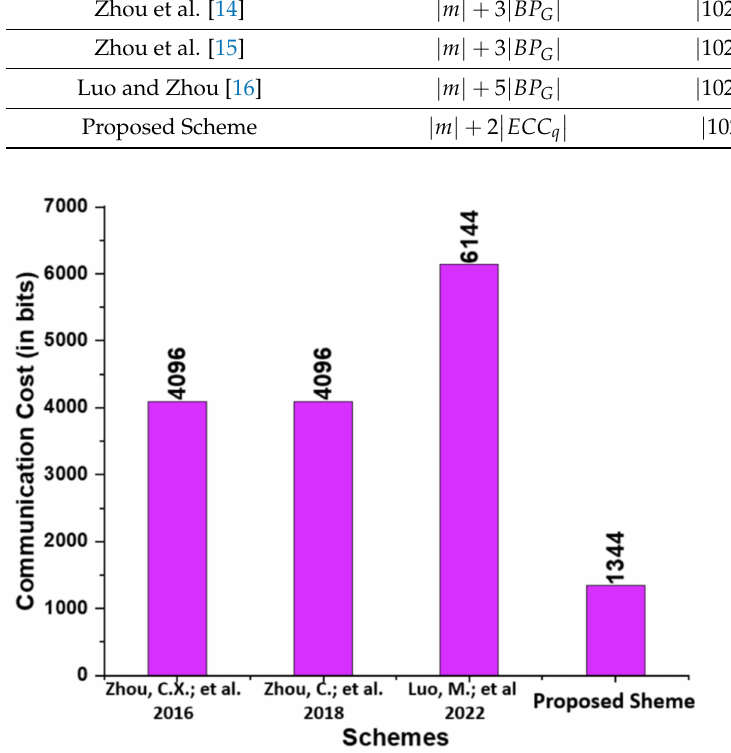
Figure 4. Comparison of communication cost (in bits)